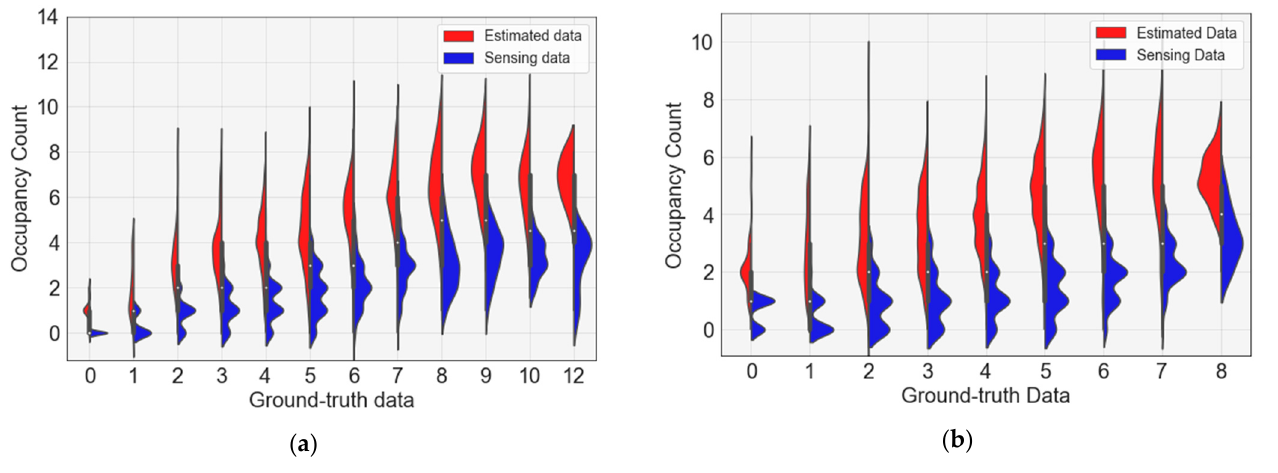
Figure 13. Analysis of occupancy count error distribution between sensing and estimated data: ( a ) occupancy distribution in room 1; ( b ) occupancy distribution in room 2.